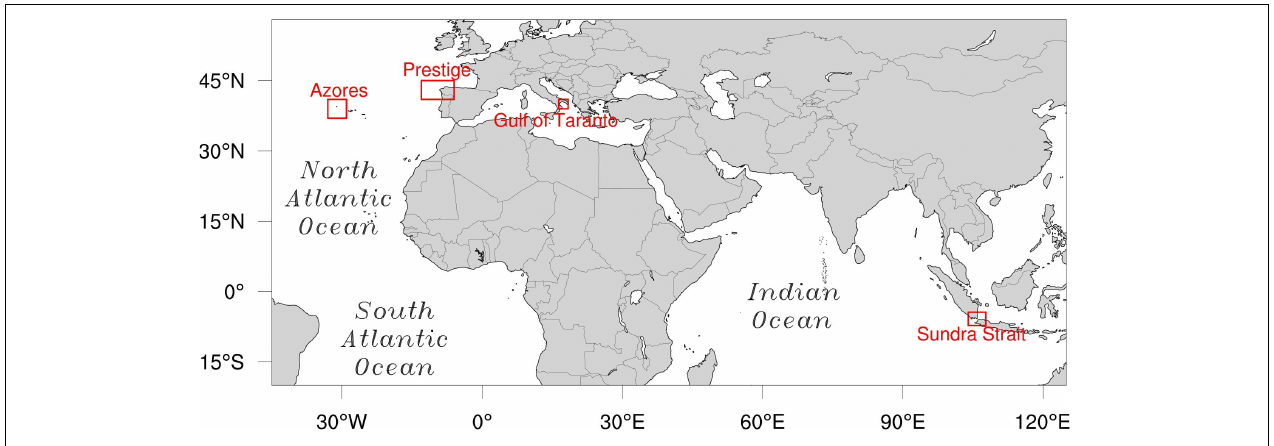
FIGURE 1 | Areas of the four case-studies experiments. Red rectangles delineate the boundaries of the nested